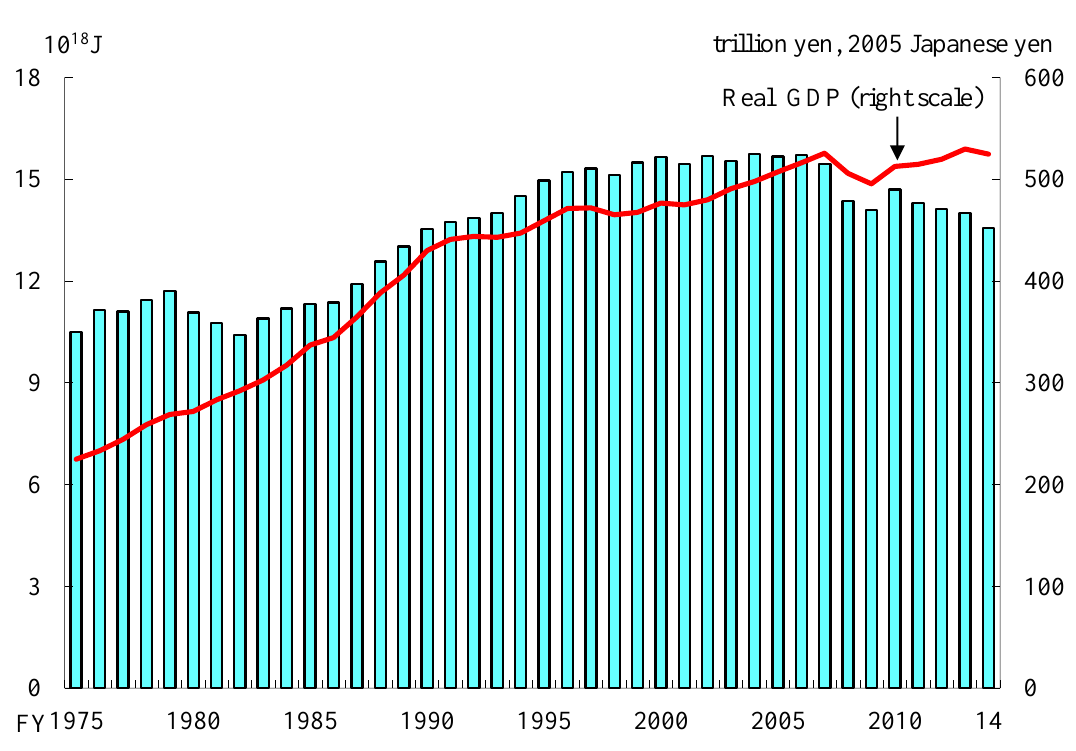
Trends in Final Energy Consumption and Real GDP